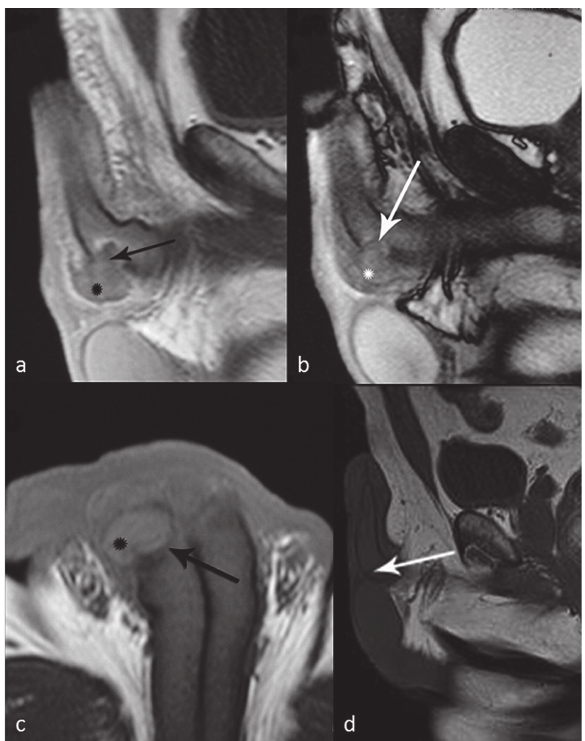
Figure 2 - A 30-year-old patient with penile fracture of the right corpus cavernosum. Sagittal T1-weighted (a) sagittal T2-weighted (b) and coronal T1-weighted (c) images show a disruption of the tunica albuginea (arrow) with surrounding haematoma in the penile midshaft (asteriks). (d) Two years later after surgical repair of the the tunica albuginea, T1- weighted image shows a thickening of the rupture site (arrow).